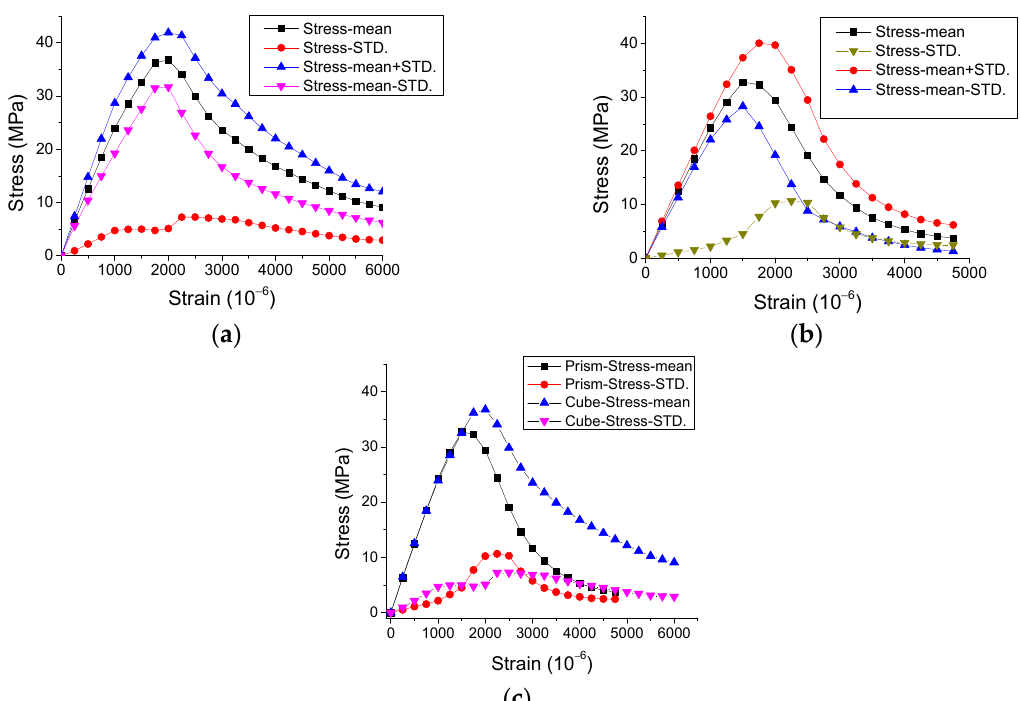
Figure 5. Mean and STD. of stress-strain response of SCC specimens under monotonic compression. ( a ) Cube specimens, ( b ) prismatic specimens and ( c ) results comparison of cube and prismatic specimens.